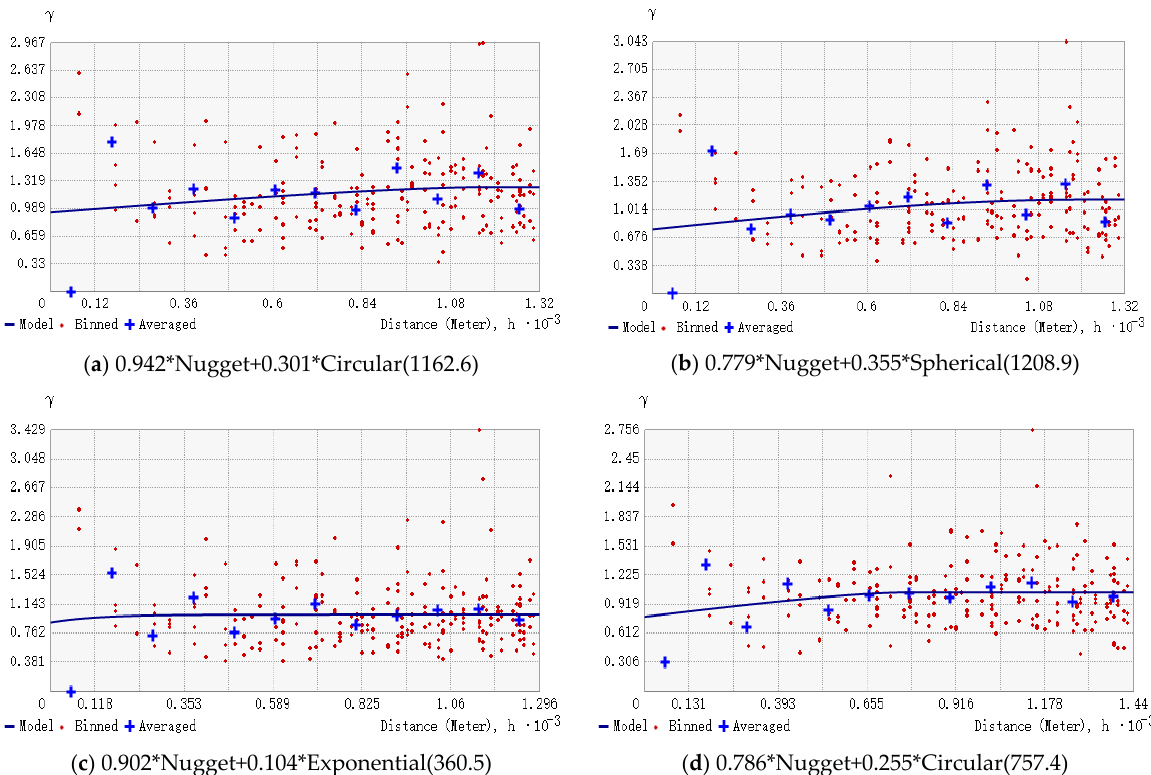
Figure 5. Semi-variance function and main parameters of the residuals of the ML models: ( a ) ranger residual error, ( b ) Cubist residual error, ( c ) GBM residual error, ( d ) BRNN residual error.